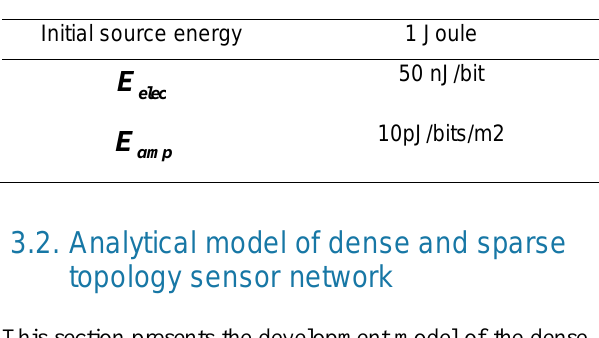
Table 2. Energy model parameters